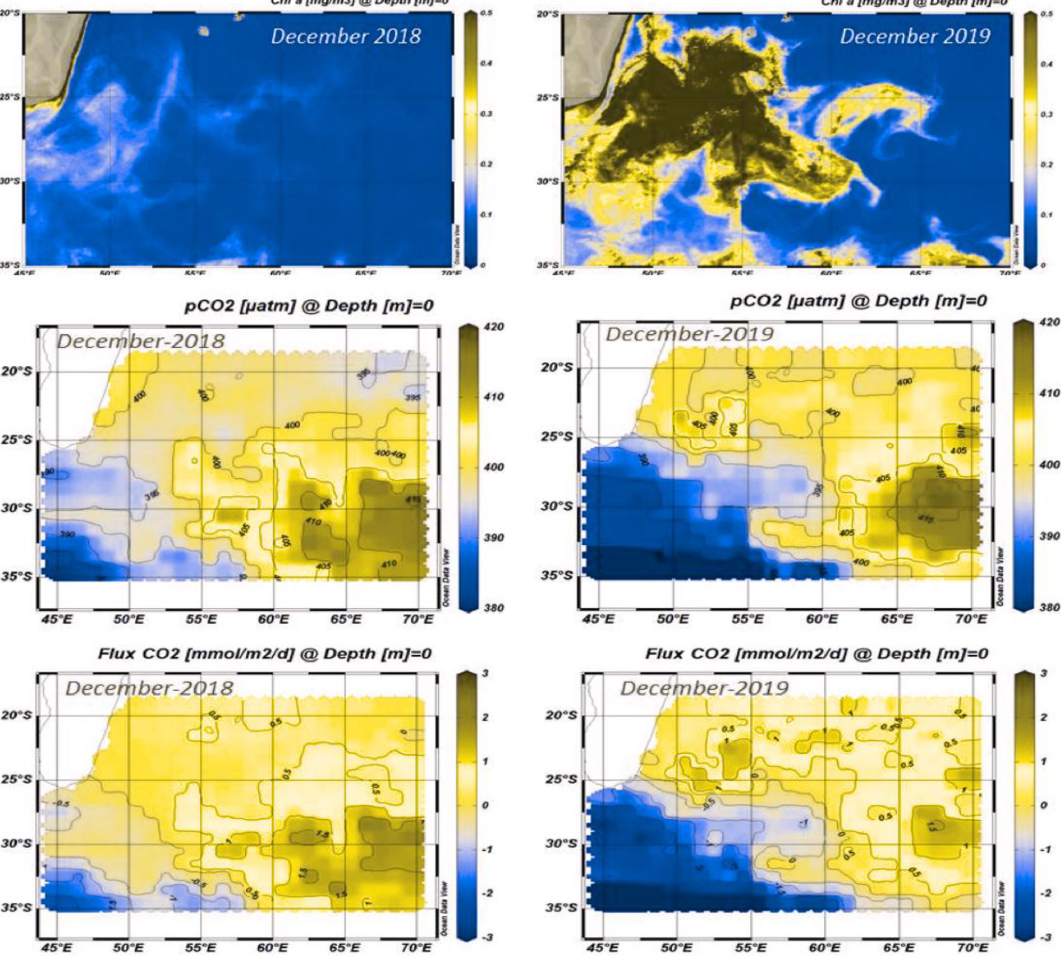
Figure 10. Maps of Chl a (mgm − 3 ), p CO 2 (µatm) and the air–sea CO 2 fluxes (mmolm − 2 d − 1 ) in the south-western Indian Ocean in December 2018 (left) and December 2019 (right). In December 2019 when the SEMB was particularly strong, the p CO 2 was lower, and air– sea CO 2 fluxes were negative (ocean sink, in blue), whereas in December 2018 when the bloom was small, the fluxes were near equilibrium or positive in this region (ocean source, yellow-brown). Chl a data downloaded from https://resources.marine.copernicus.eu/ (OCEAN-